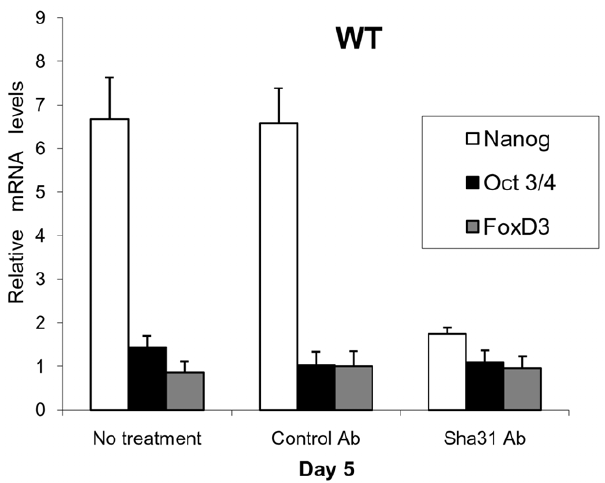
Figure 7. Blocking of PRNP by the monoclonal antibody Sha31 . On Day 5 and after 6 hours of antibody treatment, it is revealed that Nanog mRNA transcription is PRNP-dependent during differentiation and independent of feedback from the pluripotency cluster genes Oct3/ 4 and FoxD3 . (Error bars, s.e.m.).